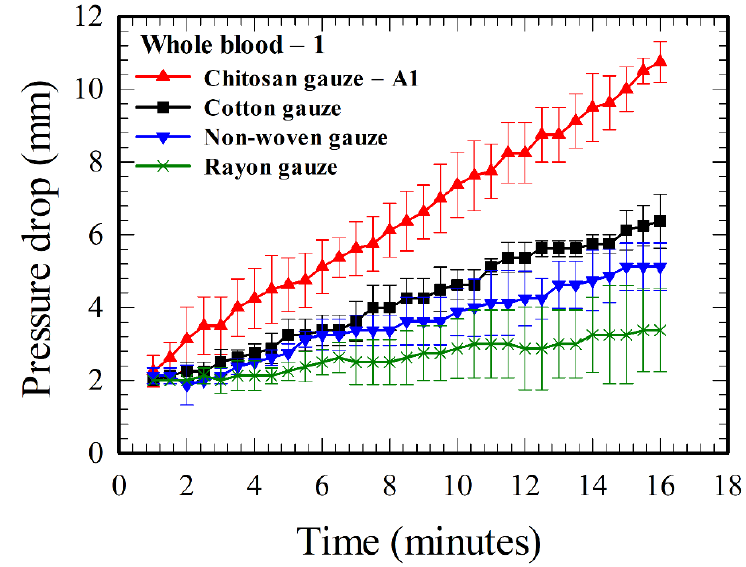
Figure 3. Time evolution of the pressure drops across various gauzes for whole blood–1.